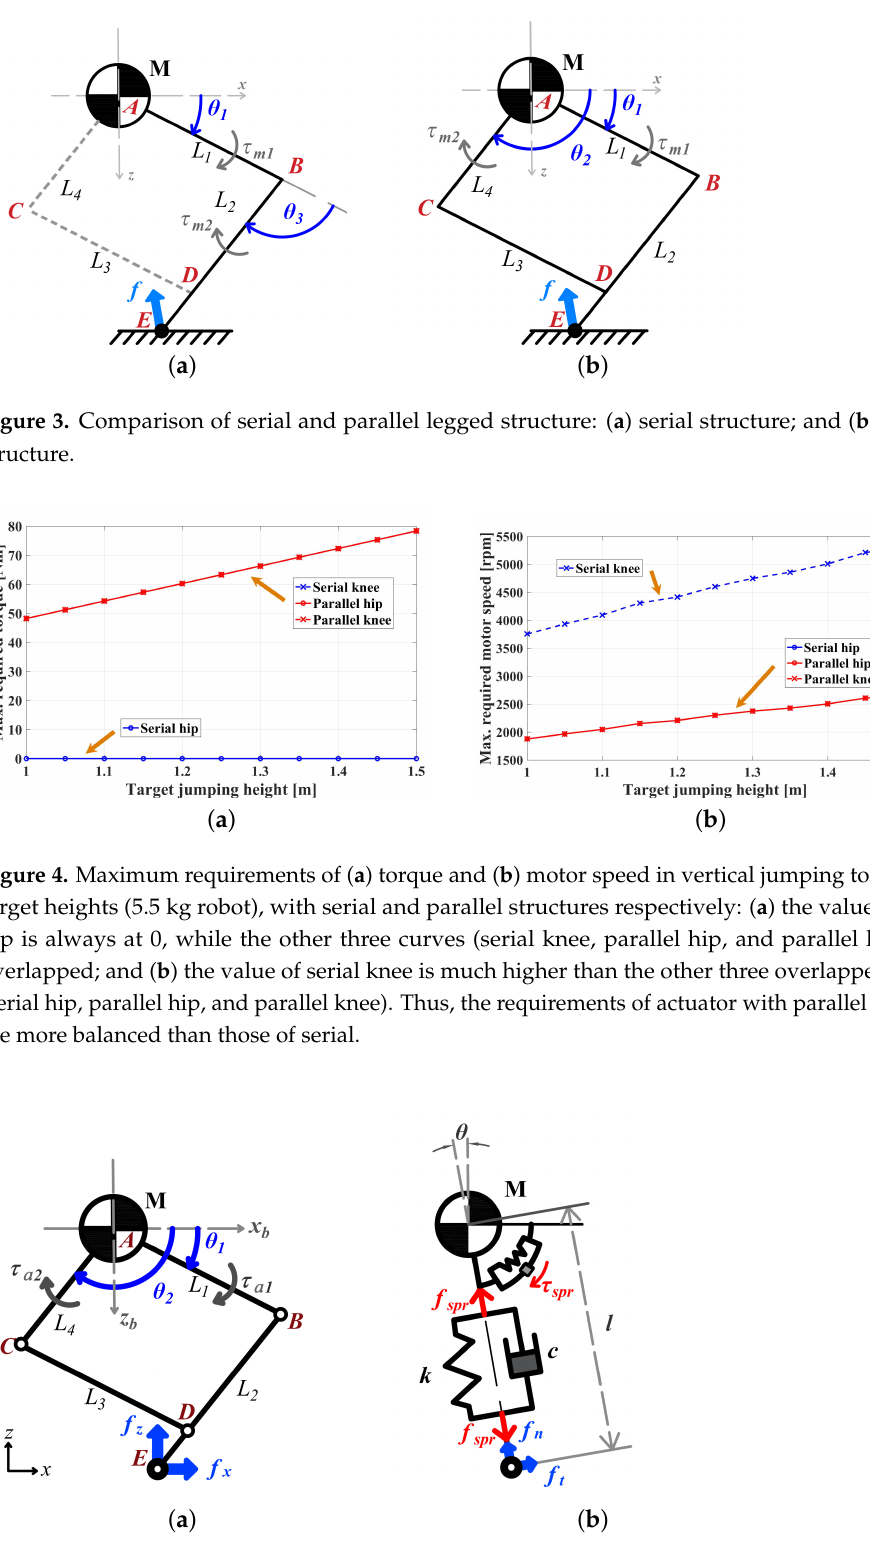
Figure 5. Virtual model control diagram: ( a ) basic structural model of parallel robot leg; and ( b ) corresponding virtual